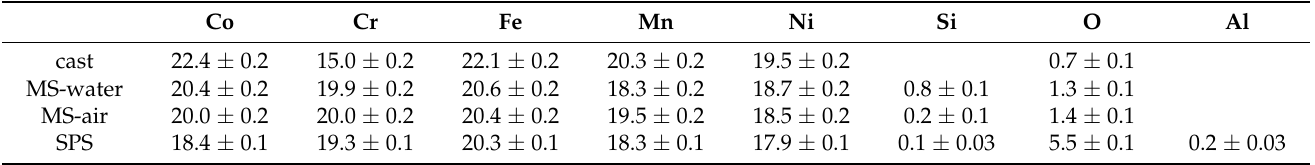
Table 1. Analyzed chemical composition of CoCrFeMnNi samples (at. %).